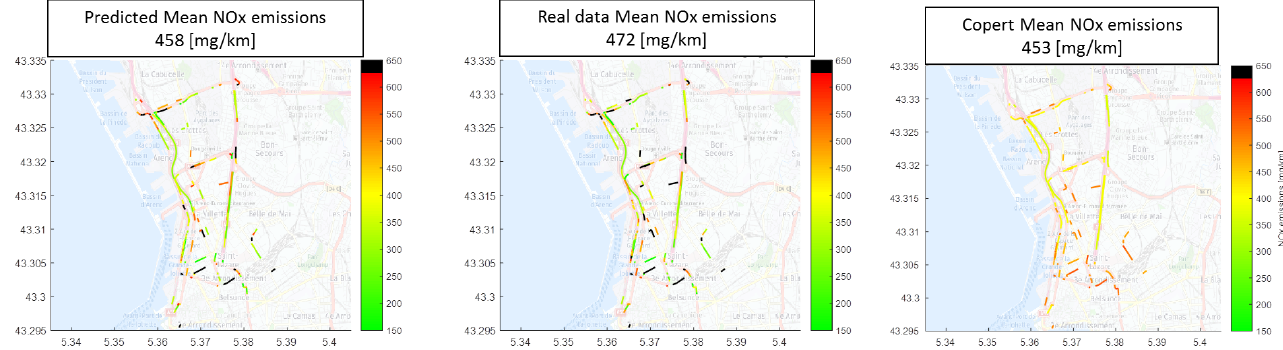
Figure 14. Map of NO x emissions in Marseilles, France, and comparison of the estimate with the reference and COPERT. Only road segments with sufficient measured driving data are displayed.